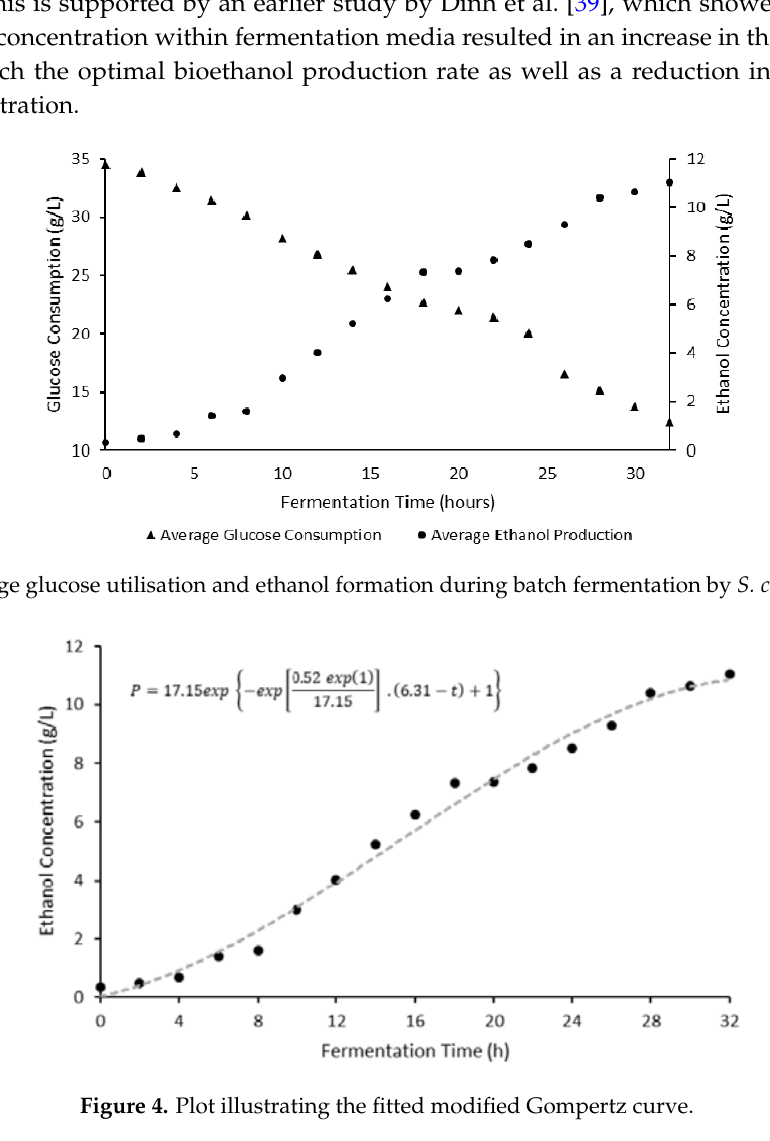
Figure 4. Plot illustrating the fitted modified Gompertz curve.